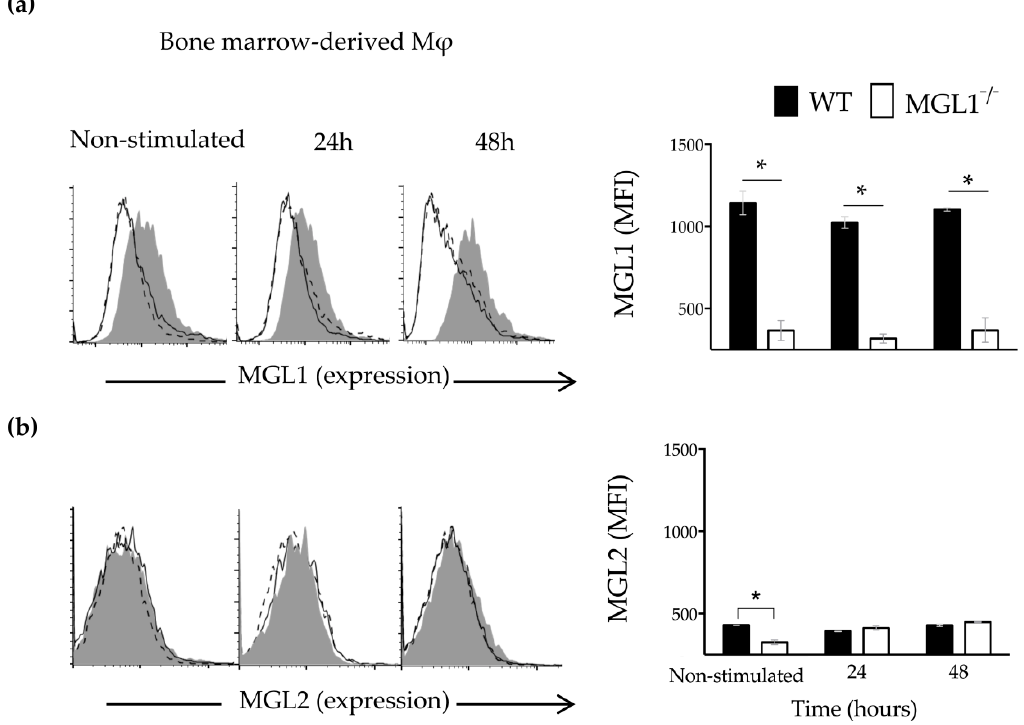
Figure 6. Expression of MGL1 and MGL2 in BMM φ in response to TcAg . BMM φ (F4 / 80 + ) from WT or MGL1 − / − mice were stimulated for 24 or 48 h with Tc Ag (25 µ g / mL). Representative histogram and bar chart of the percentage of BMM φ expressing MGL1 and MGL2 are shown in ( a ) and ( b ), respectively. Dotted line, isotype; gray area, M φ from WT mice; solid line, M φ from MGL1 − / − mice; n = 6 mice per group; and * p < 0.05.